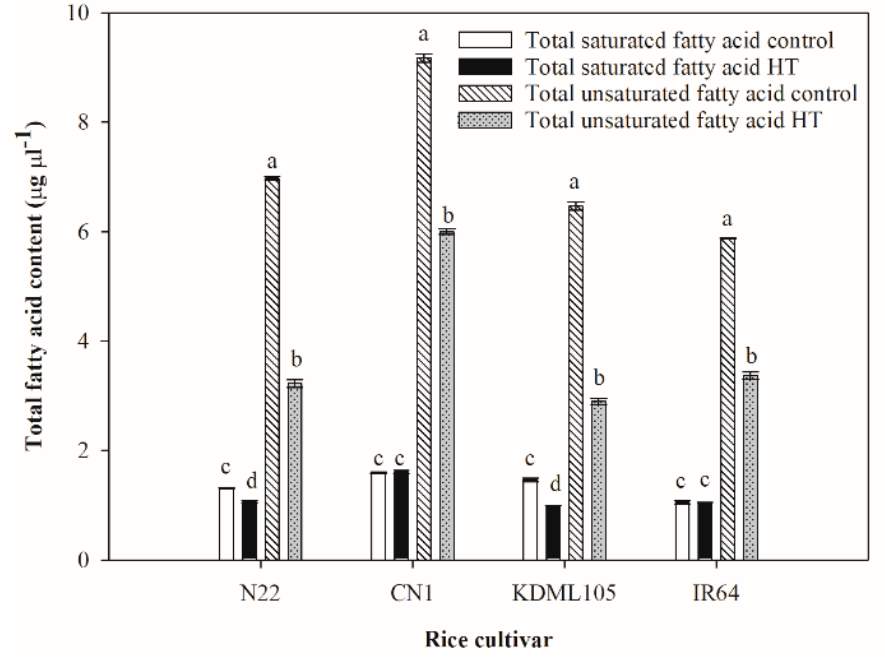
bar represents mean ± SE ( n = 3–4). Asterisk (*) indicates significant difference between control and HT in each rice cultivar at p ≤ 0.05 by t test. Different capital letters indicate significant difference of control group in different rice cultivars at p ≤ 0.05 by ANOVA and DMRT, and small letters indicate significant difference of HT in different rice cultivars at p ≤ 0.05 by ANOVA and DMRT.